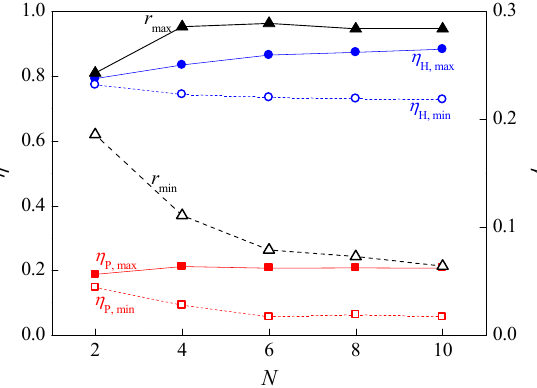
Figure 11. Results of the maxima and minima of the two efficiencies η (left y ‐ axis) and the power to heat ratio r (right y ‐ axis) for varied number of mirrors N in configuration 1.